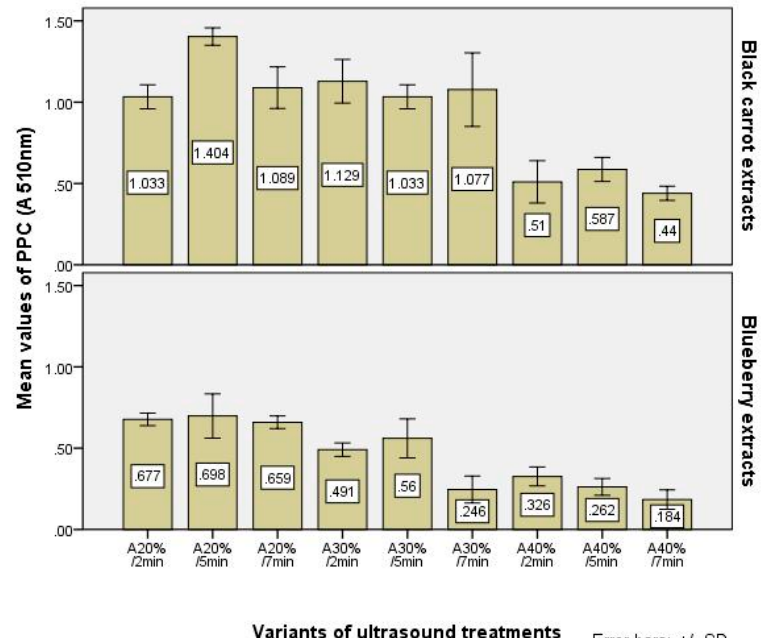
Figure 3. Effects of the ultrasound treatments and of extracts additions (for obtaining cider enriched with antioxidants) on the protein precipitation capacity (A 510 nm). Data are means of 3 experiments (n = 3). Abbreviations: PPC—protein precipitation capacity; A 510 nm—absorbance value at 510 nm; A—amplitude of ultrasounds.